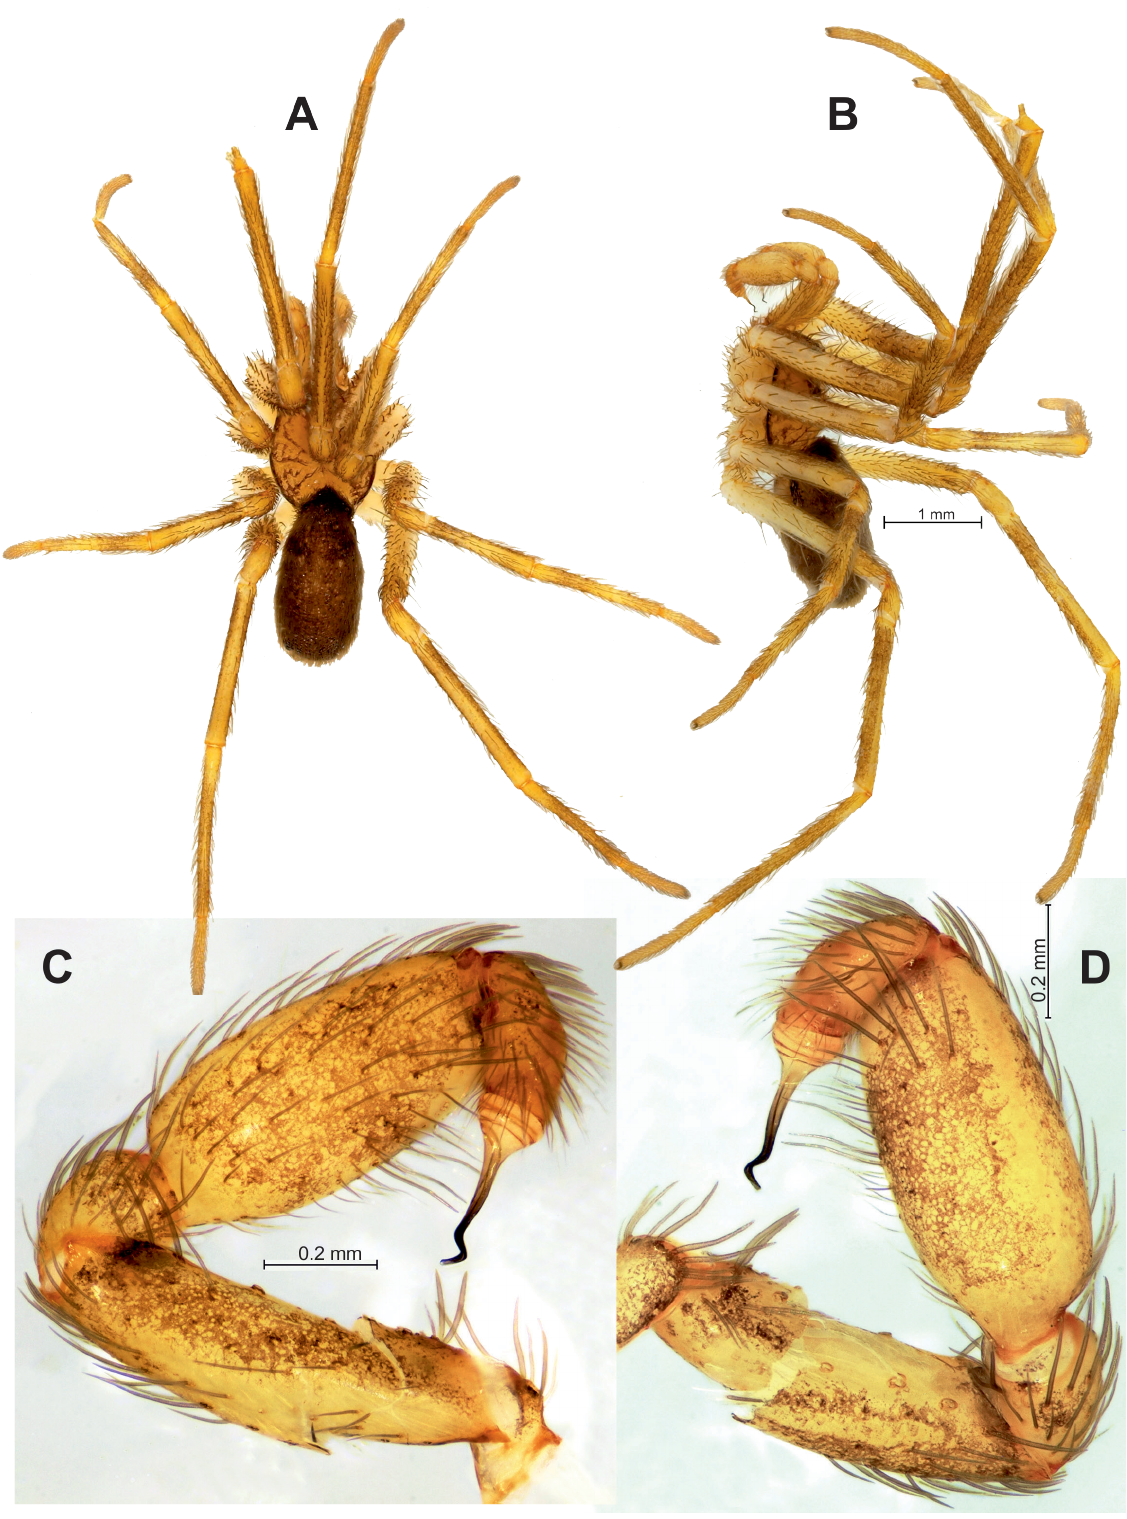
Fig. 13. Somatic characters and palp of Zaitunia minoica sp. nov., holotype, ♂. A–B . Habitus, dorsal and lateral. C–D . Palp, pro- and retrolateral. Scale bars: a–B = 1.0 mm. C–D = 0.2